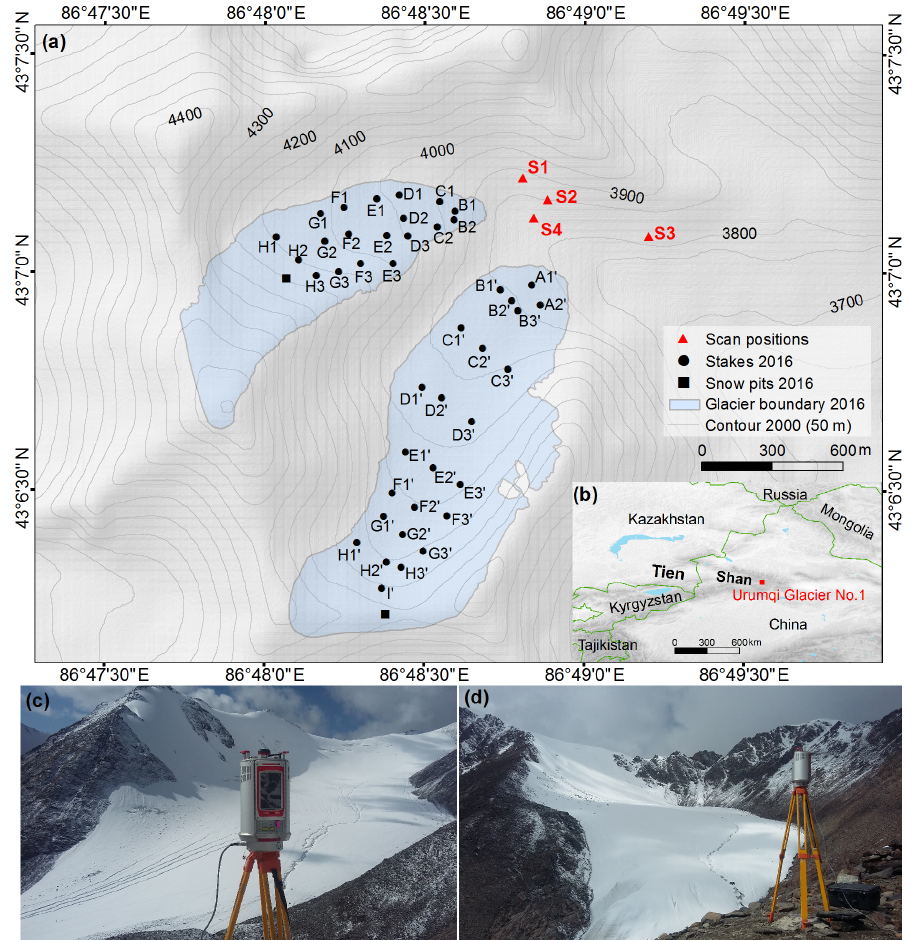
Figure 1. Overview of the study area. (a) The glaciological mass-balance measuring network in 2016; glacier boundary delineated from TLS-derived DEM (1 September 2016) and spatial distributions of four scan positions. (b) Location map of Urumqi Glacier No. 1 in the eastern Tien Shan; the hillshade in the background and national boundary are from the Shuttle Radar Topography (SRTM) DEM and the ESRI (Environmental Systems Research Institute), respectively. (c) Riegl VZ ® -6000 TLS survey of the east branch at scan position S2 and (d) TLS survey of the west branch at scan position S1 (27 August